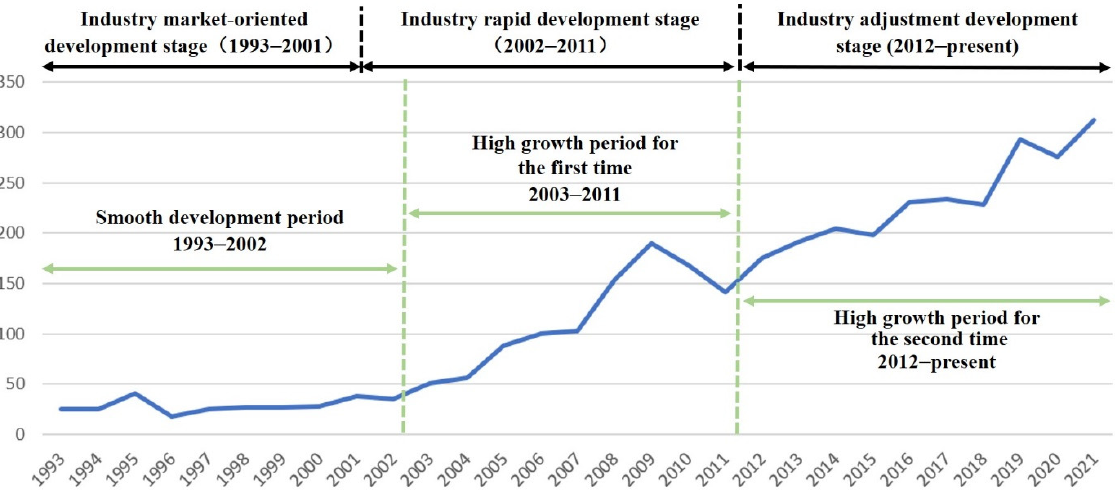
Figure 3. Overall trends in the number of papers on coal mine accidents in